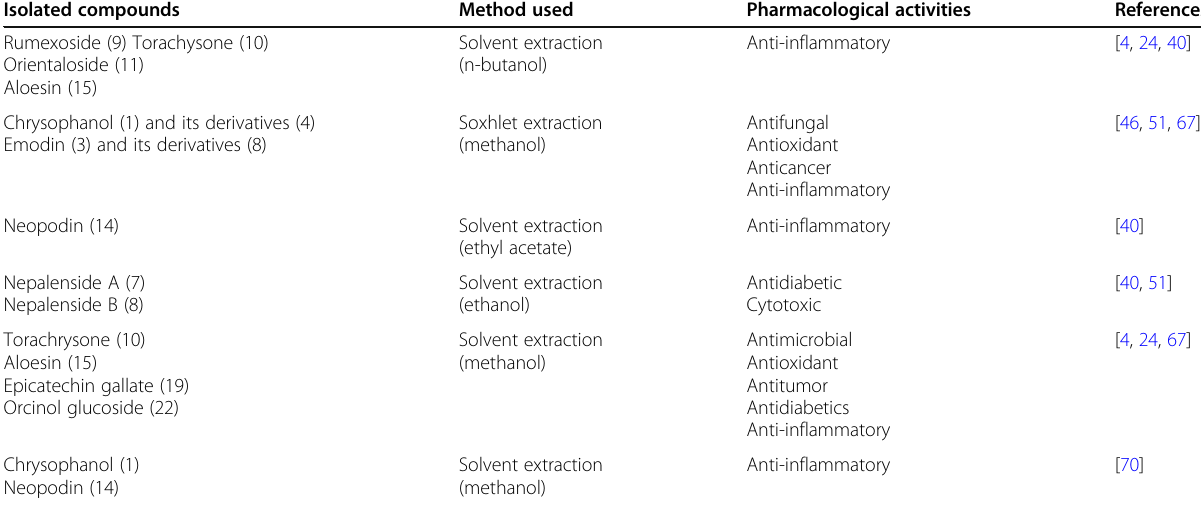
Table 3 Major compounds isolated from root extracts of R. nepalensis and their pharmacological activities Isolated compounds Method